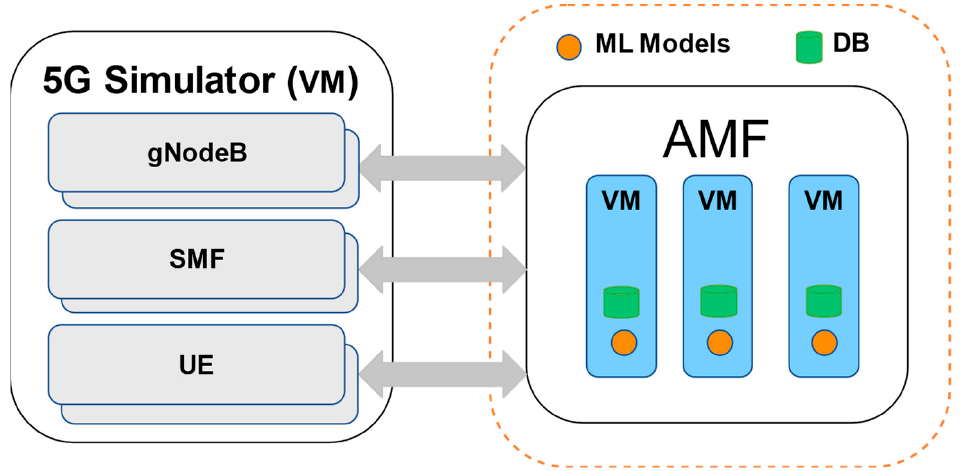
Figure 9. Experiment environment for proposed paging.